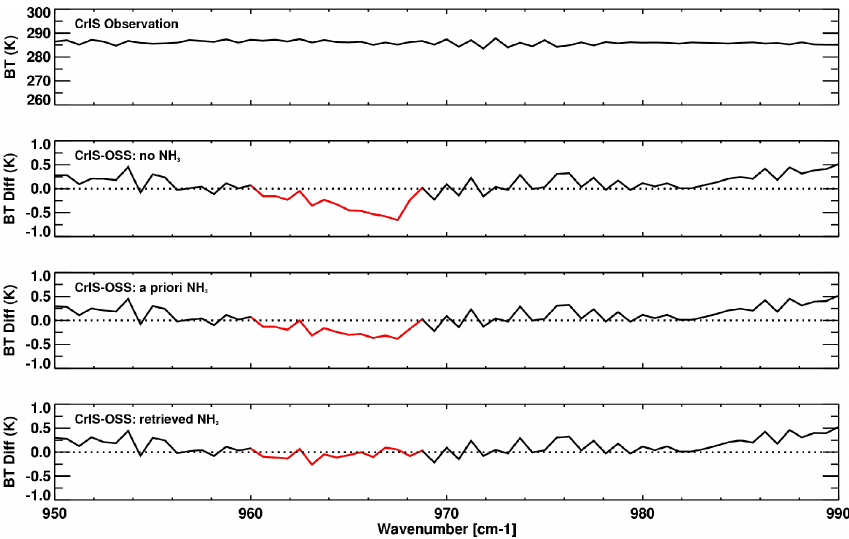
Figure 6. Top panel: Observed CrIS brightness temperature spectrum over the San Joaquin Valley (35.97 ◦ N, 119.28 ◦ W on 28 January 2013). Second panel from the top: Brightness temperature residuals (observed minus OSS simulation) with no NH 3 included in the atmospheric profile. Third panel from the top: Brightness temperature residuals after the addition of an NH 3 profile with a mixing ratio of 17.4ppbv at 908hPa. Bottom panel: Difference between the OSS model runs in the second and third panel from the top, showing the spectral signature of NH 3 at the CrIS resolution. The red line in the residual plots highlights the spectral region used in the NH 3 retrievals.